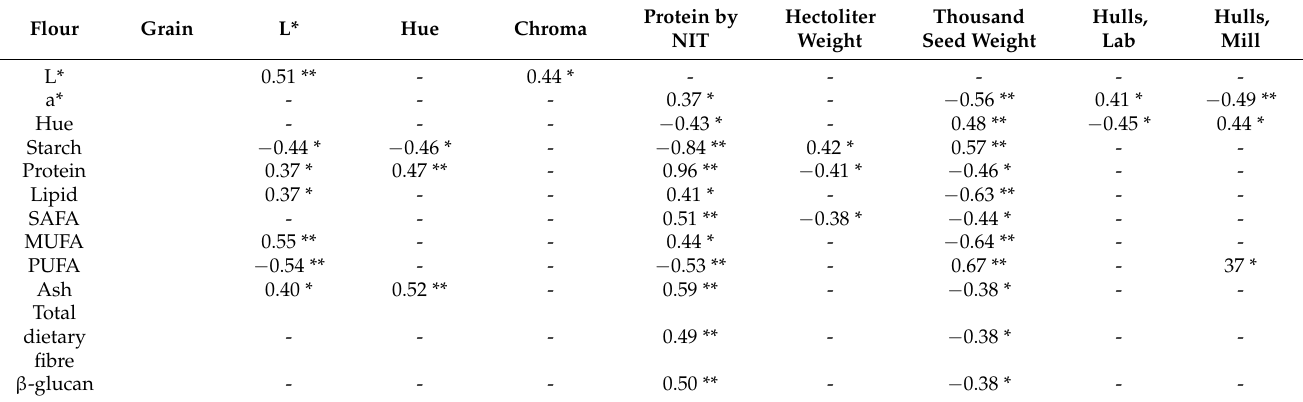
Table 4. Pearson correlation coefficients of the oat grain and heated oat flour properties. Flour